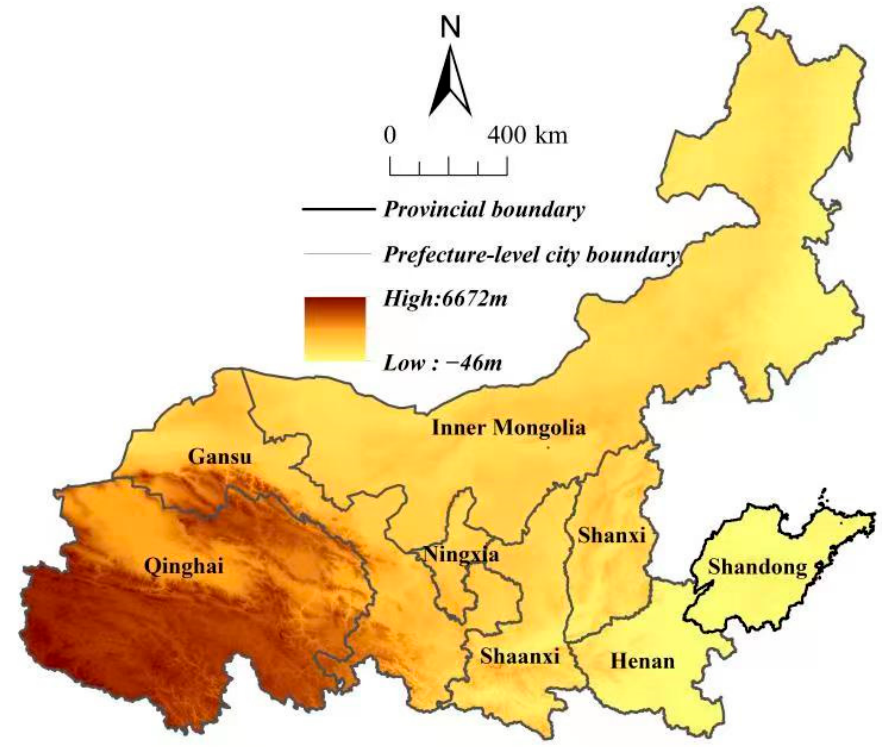
Figure 1. Location of the study